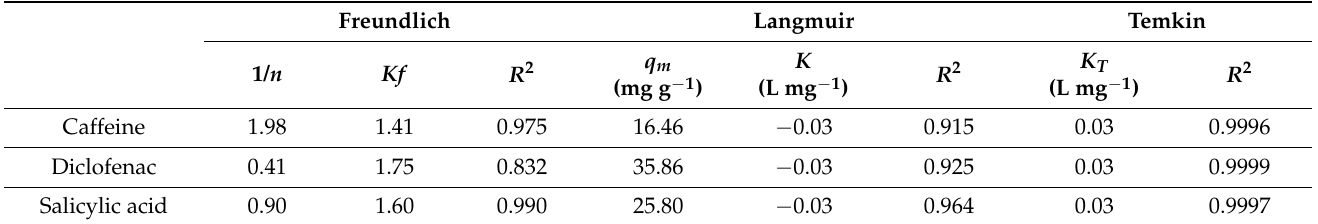
Table 10. Parameters obtained by fitting adsorption data in selected isothermal models. Own compilation based on literature data